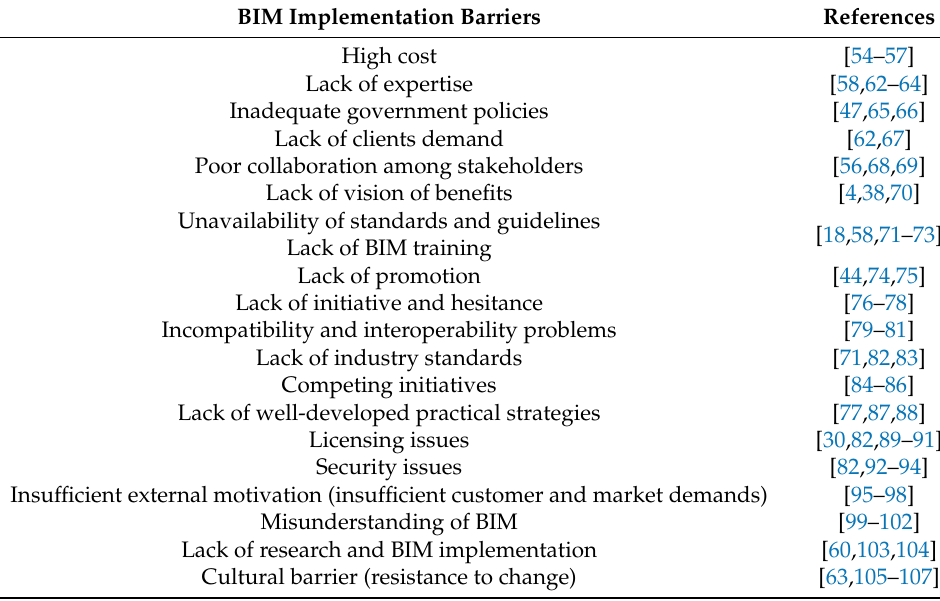
Table 1. Building information modeling (BIM) implementation